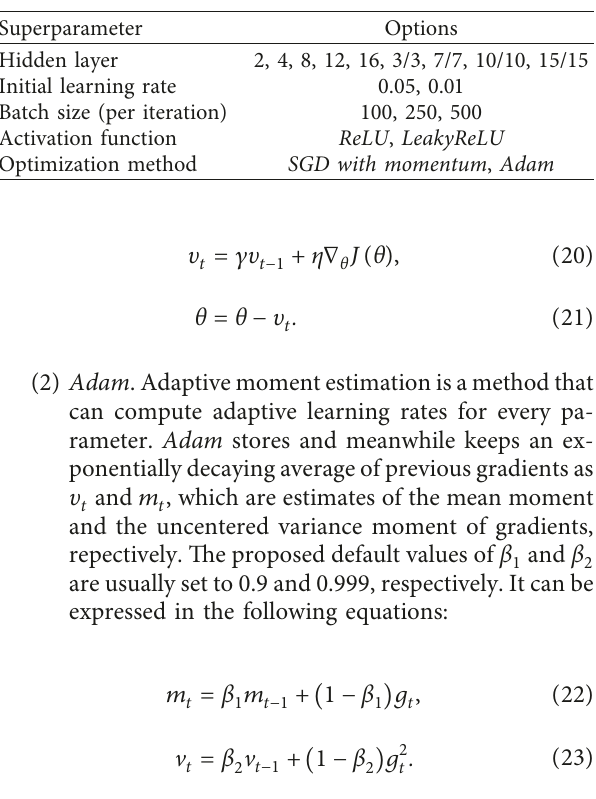
Table 4: Optional parameters of